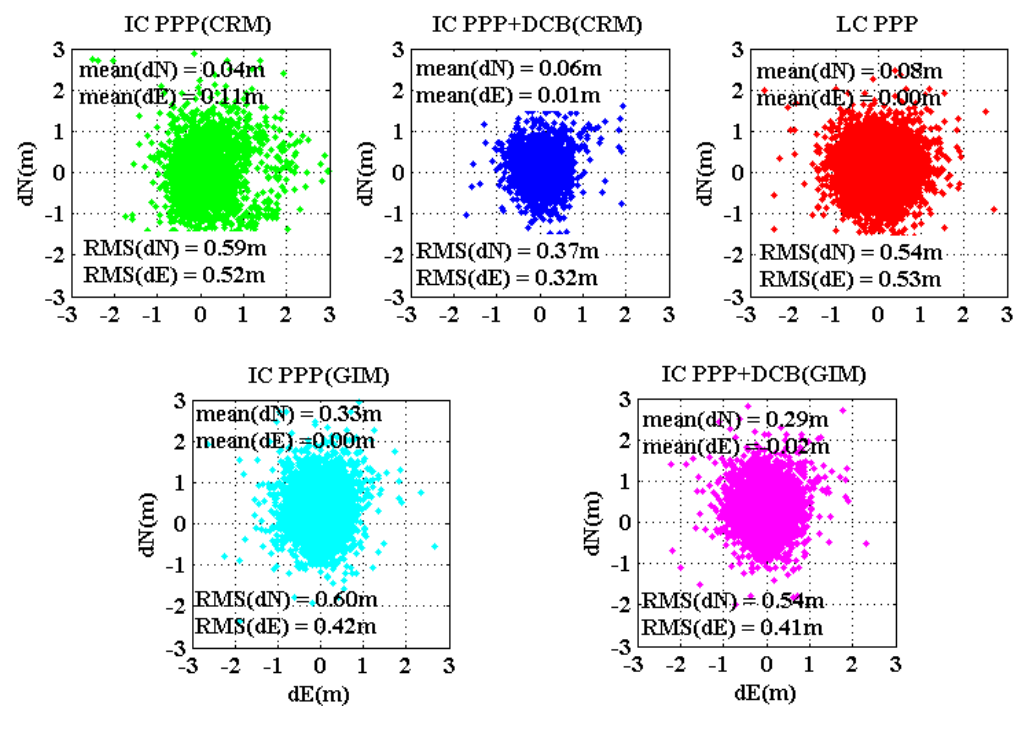
Figure 9. Initial horizontal positioning results for the five PPP schemes. The position of the first three epoches are counted and plotted for all the convergence